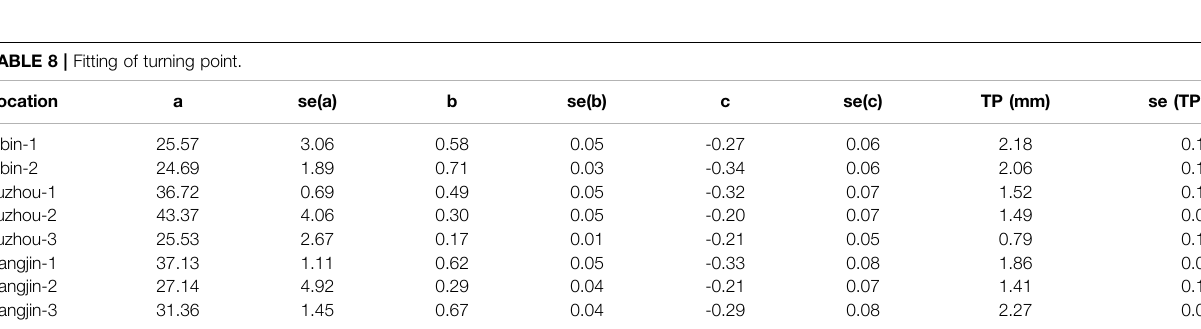
TABLE 8 | Fitting of turning